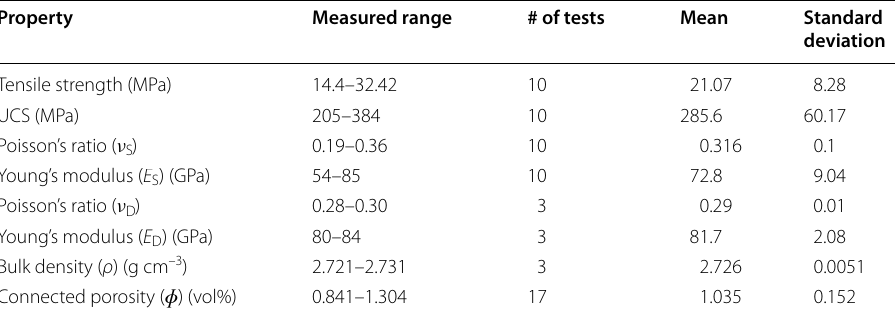
Table 2 Summary of the measured physical properties of Waipapa greywacke from this study Property Measured range